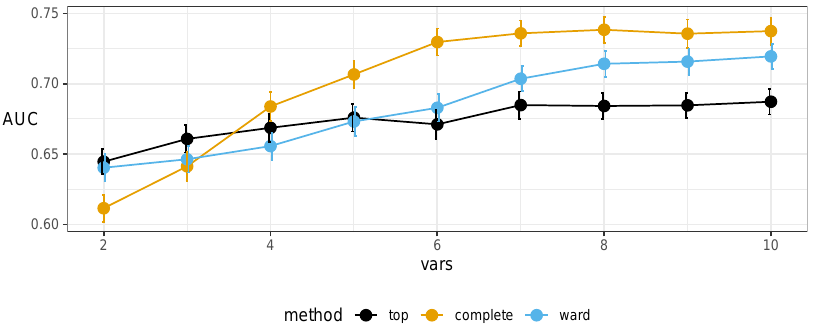
Figure 4. Plots of area under the receiver operating characteristic curve (AUC) of Random Forest classifiers using markers selected by the top- n approach and two variants of hierarchical clustering inside our proposed protocol (complete linkage and Ward’s criterion). These results were obtained in external 10-fold cross validation (CV). Internally, for the protocol, 10-fold CV was used to ensure enough samples. Error bars denote the standard error. The complete linkage variant exhibits the desired behavior, achieving the best results earliest, with a plateau starting at